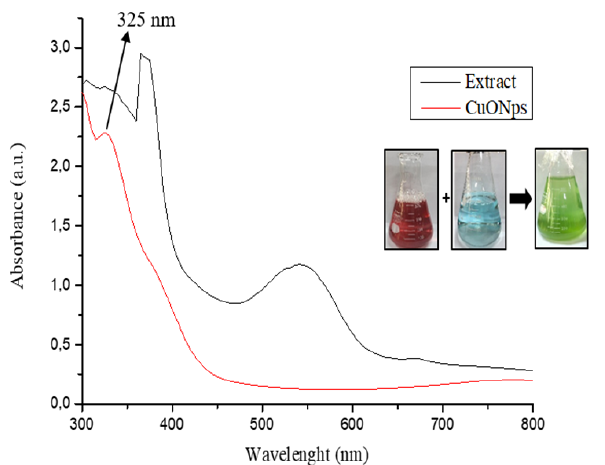
Fig. 3. UV-Vis spectra CuONPs and Extract Anredera cordifolia The results of UV-Vis spectrophotometer analysis of Anredera cordifolia leaf extract and copper oxide nanoparticles showed a number of differences in wavelength absorption peaks indicating a peak shift during the